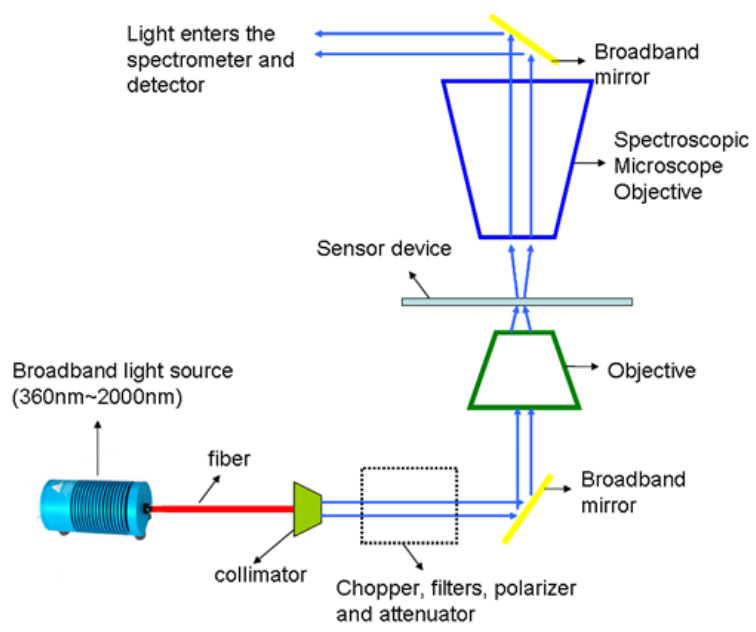
Figure 6. Schematic of measurement setup.